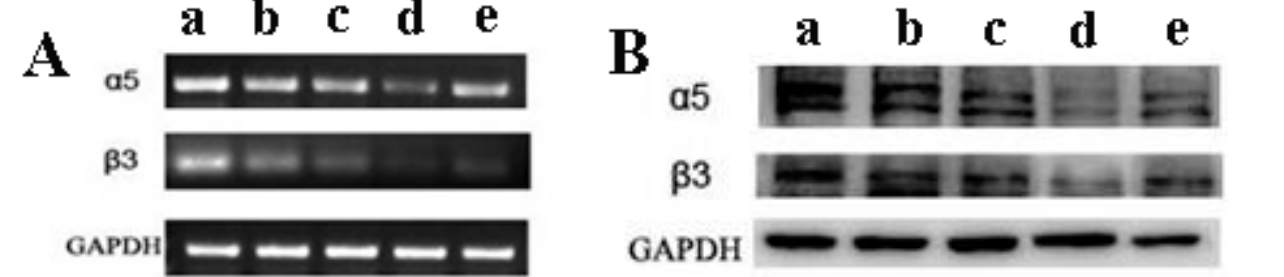
Figure 9. Expression of α α β 3 integrin; ( B ) protein expression of α V drug); ( b ) group TMZ; ( c ) group TMZ/PLGA; ( d ) group TMZ/PLGA/S-nHA; ( e ) group